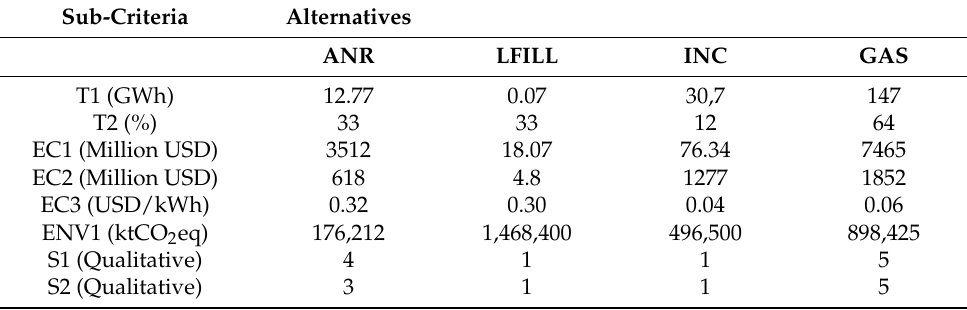
Table 5. Decision